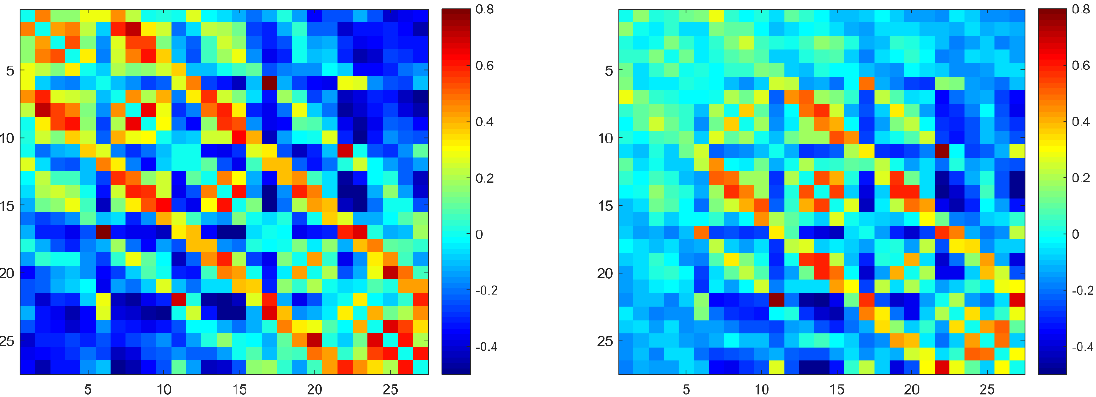
Figure 3. The correlation matrices of the two groups (left, Hangzhou; right, Xining; digits in the matrices represent channels).